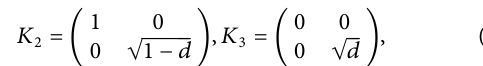
Frontiers in Physics |